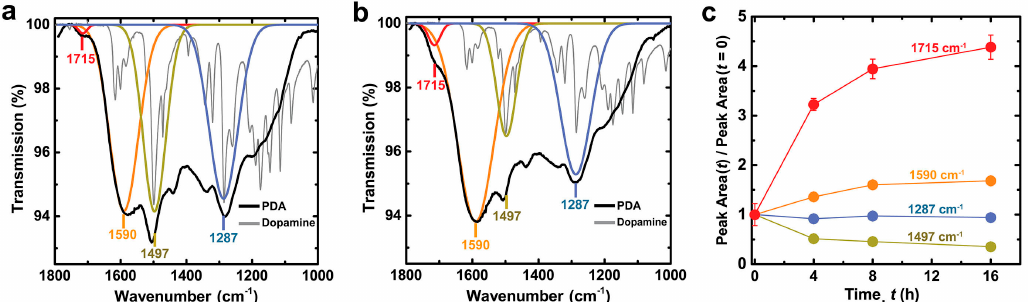
Figure 4. Attenuated total reflectance-infrared (ATR-IR) spectra of PDA films that were incubated in 300 mM CaCl 2 50 mM Tris buffer pH = 9.5 for: ( a ) 0 h; and ( b ) 4 h. The spectrum of stock dopamine powder is also shown and scaled for clarity; ( c ) Change in ATR-IR peak area vs. incubation time relative to the value for the pristine PDA film. See Figures S9 and S10 for data at 8 and 16 h and additional deconvoluted peaks. Data are represented as the average ± SD ( n = 6 measurements at random locations on the sample).